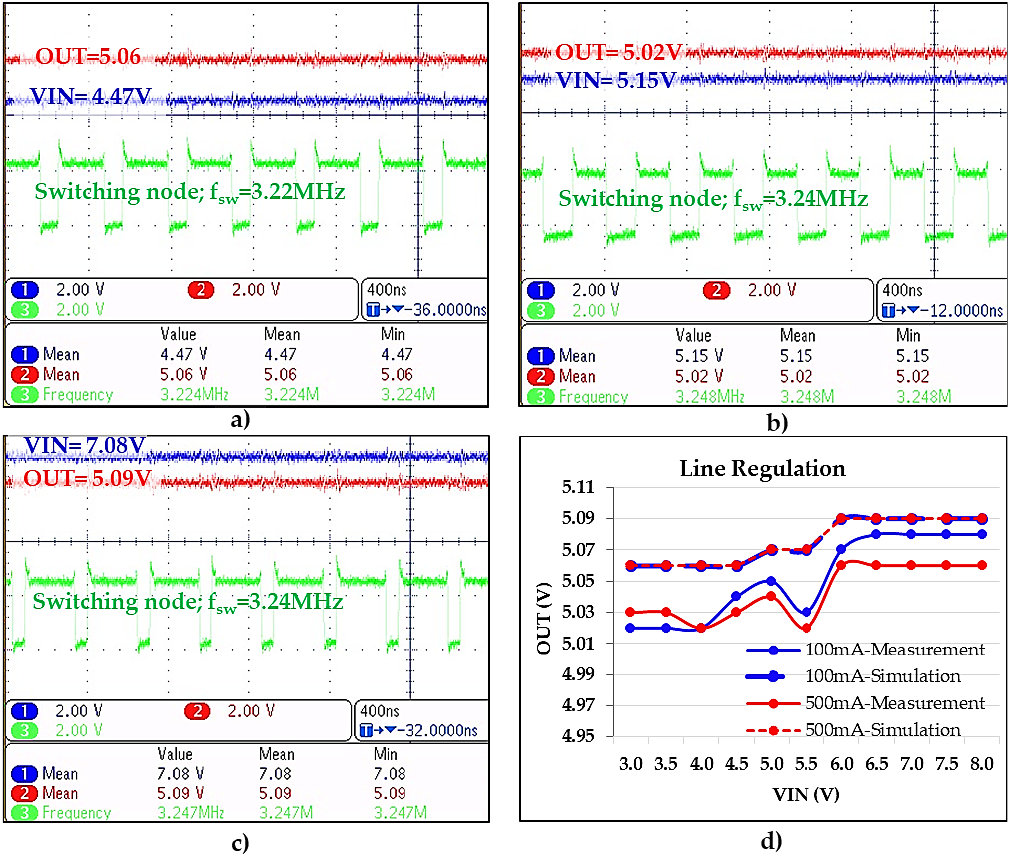
Figure 11. Measurement results in the buck, buck-boost, and boost modes when ( a ) VIN = 4.47 V; ( b ) VIN = 5.15 V and ( c ) VIN = 7.08 V; and ( d ) Comparison of line regulation in simulation and measurement.